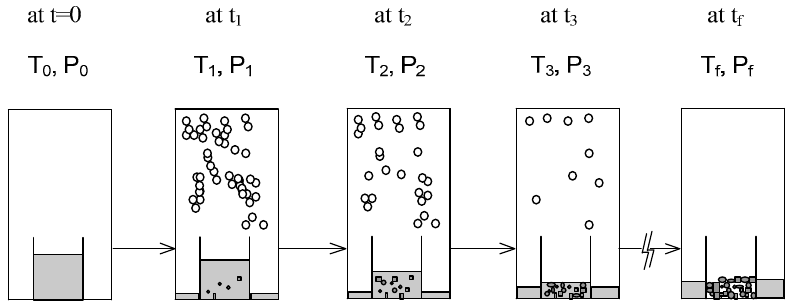
Figure 4. Schematic diagram of a batch SC experiment, where each stage corresponds to a three-phase transformation state at a given time: At t = 0, a mixture melt in the sample container; at 0 < t < t f , formation of R -phenylglycinol crystalline product and mixture vapor from a mixture melt due to the three-phase transformation; at t f , only R -phenylglycinol crystalline product and the remaining melt left in the sample container. Note that the vapor was condensed and collected outside the sample container in the